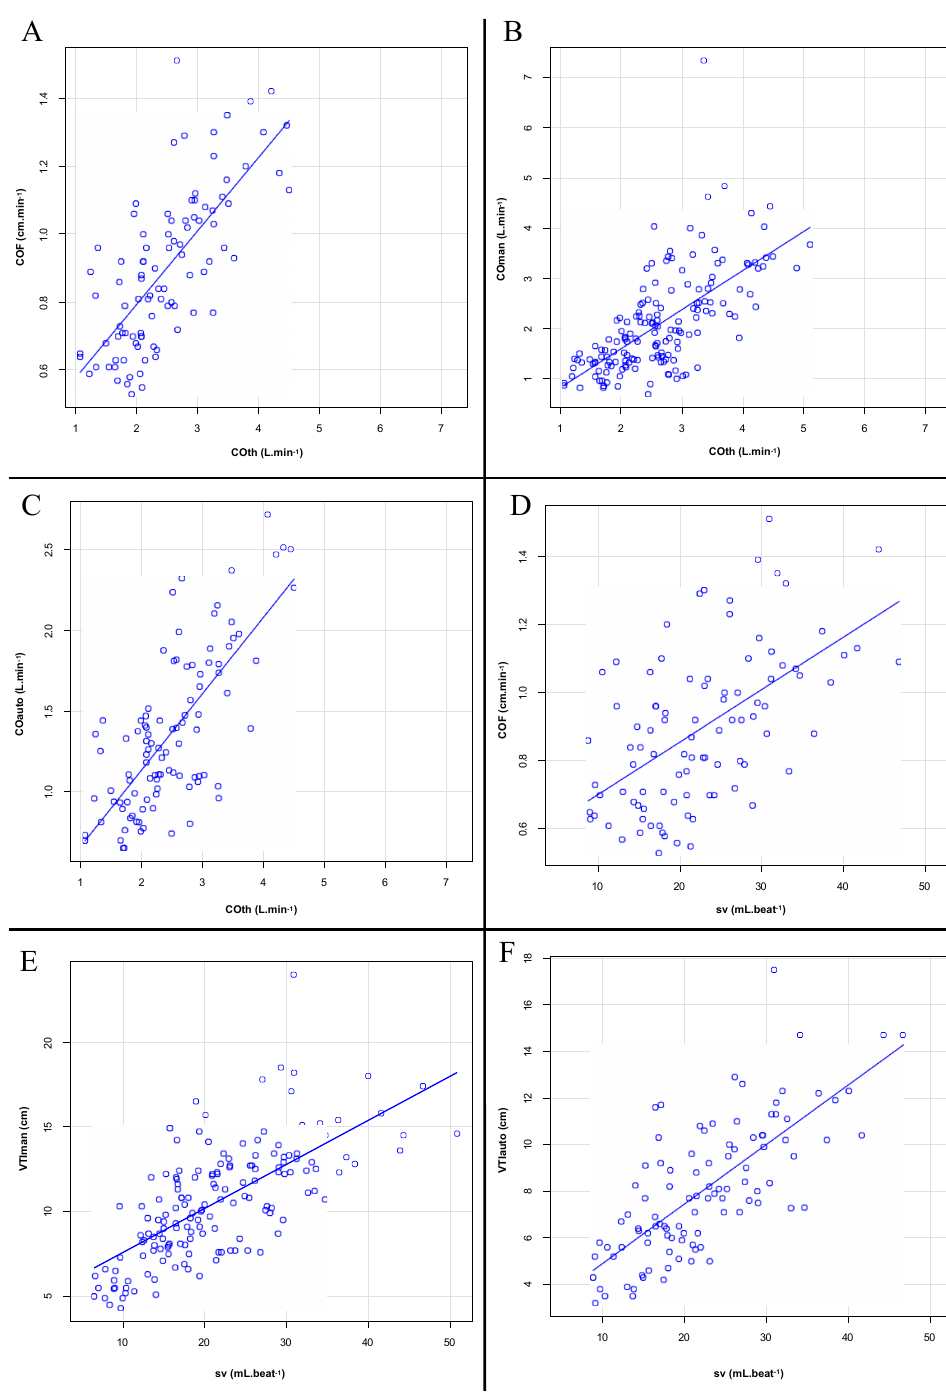
Figure 4. Scatter plots showing the correlations between CO measurements. ( A ) CO as measured by thermodilution (COth) and CO Flux (COF); ( B ) COth and CO calculated by ultrasound device with a manually measured sub-aortic velocity time index (COman); ( C ) COth and CO calculated by ultrasound device with an automatically measured sub-aortic velocity time index (COauto); ( D ) stroke volume (SV) and COF; ( E ) SV and a manually measured sub-aortic velocity time index (VTIman); ( F ) SV and an automatically measured sub-aortic velocity time index (VTIauto).